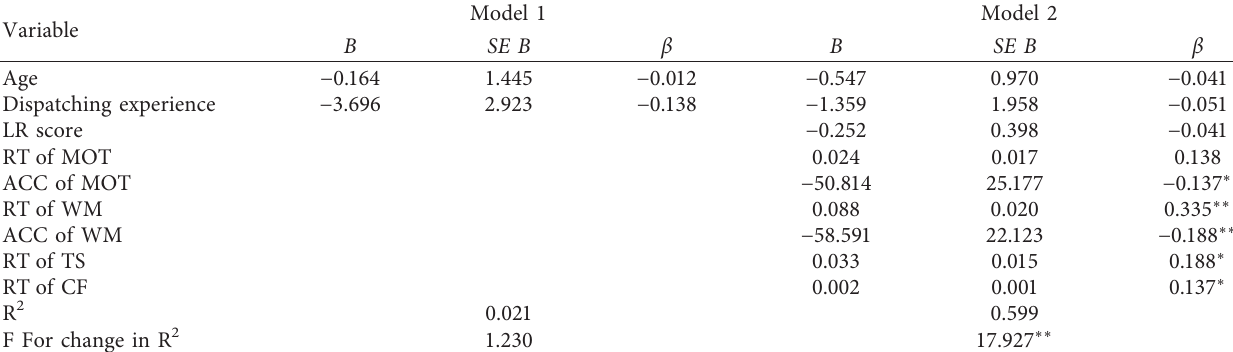
Table 5: Hierarchical regression coefficients for the prediction of train delay